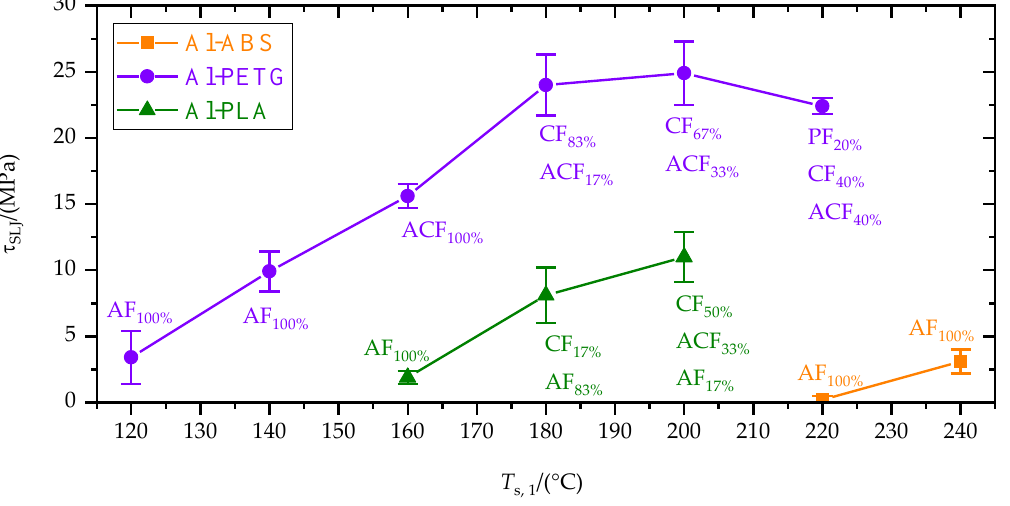
Figure 10. Tensile single-lap-shear strength, τ SLJ , as a function of substrate temperature, T s,1 . Percentages of the failure patterns: polymer part failure (PF, outside the joining area), cohesive failure (CF), adhesive failure (AF) and mixed adhesive and cohesive failure (ACF) are given.